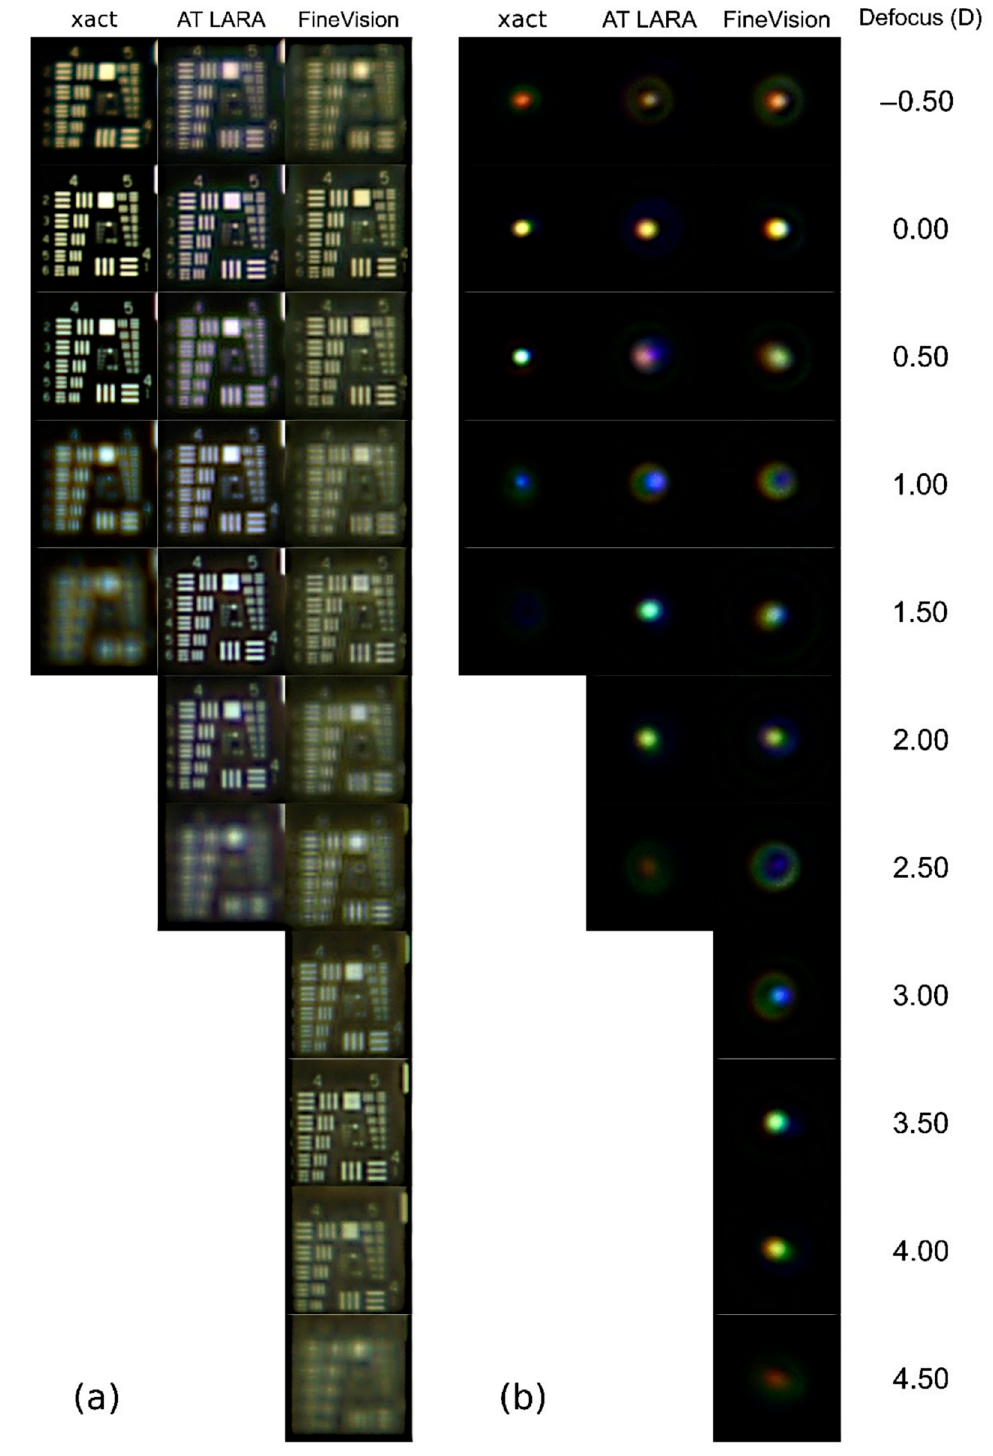
Figure 2. Through-focus images of the studied IOLs for the ( a ) USAF test and ( b ) a 30 µm pinhole as object tests. object